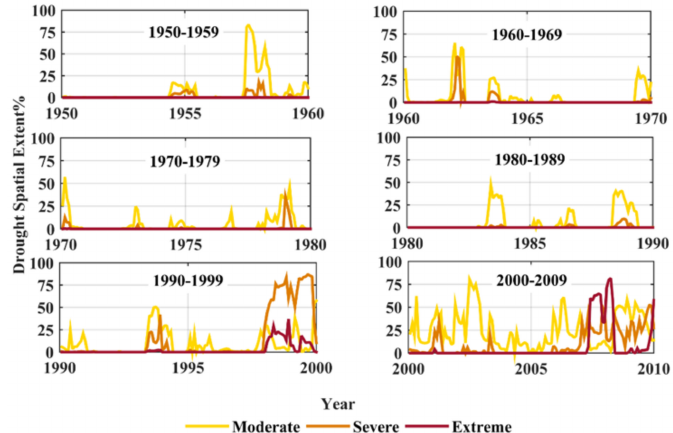
Figure 2. Decadal variations of drought spatial extent over Iraq.